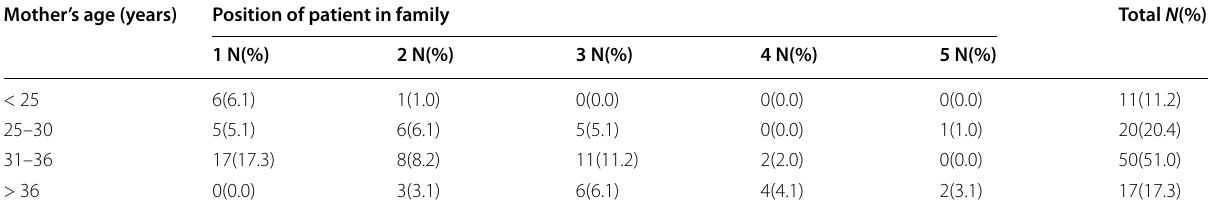
Table 4 Cross tab between mother’s age and position of patient in family Mother’s age (years) Position of patient in